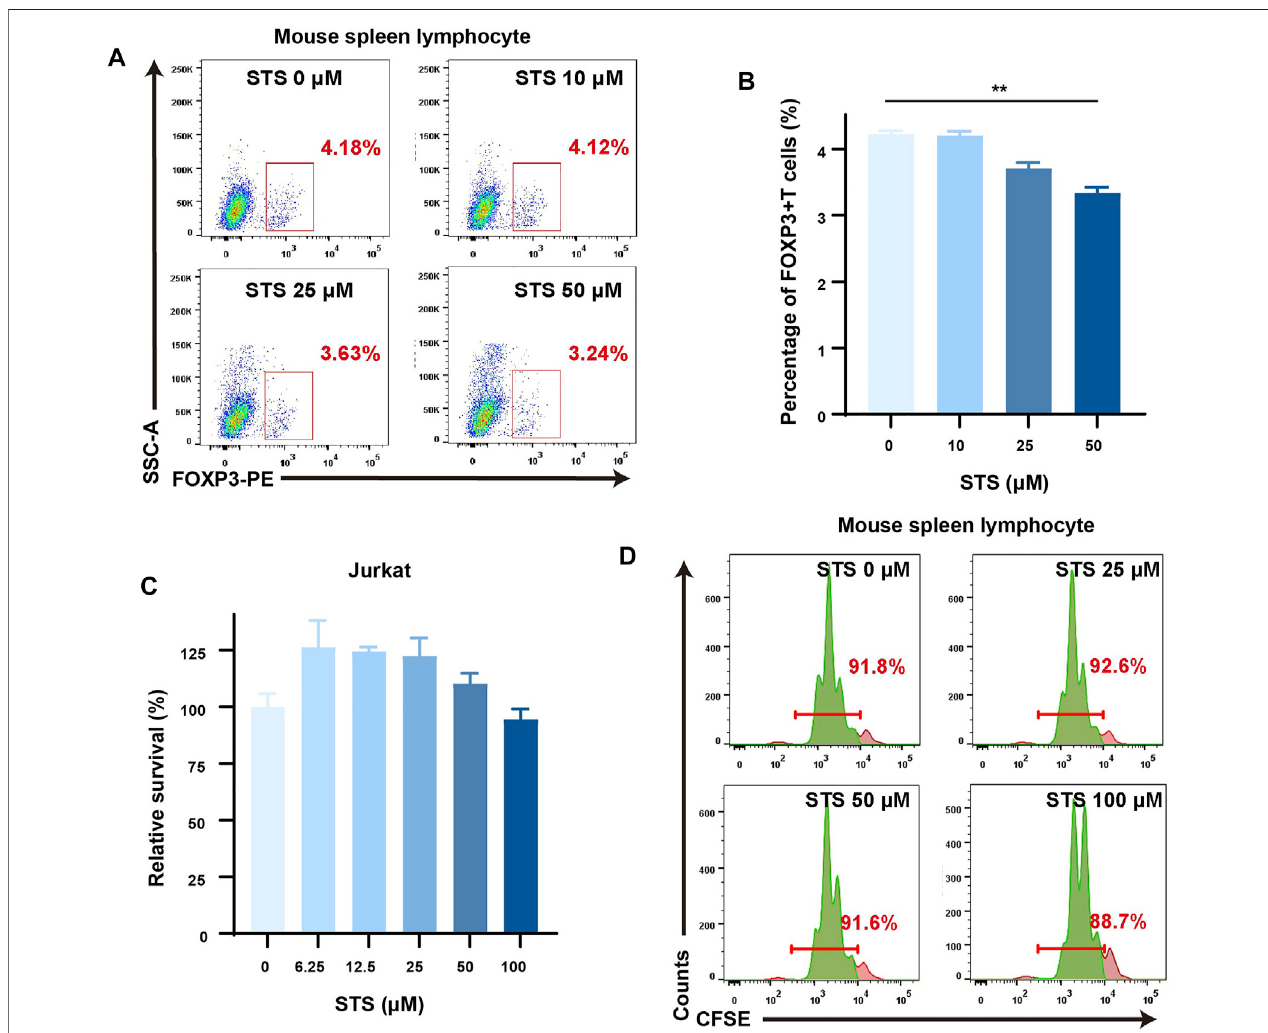
FIGURE 3 | STS reduced the percentage of Treg cells with a slight effect on the proliferation of lymphocytes. (A) STS decreased the percentage of Tregs. Flow cytometry was employed to analyze the percentage of Tregs in the coculture system of murine spleen lymphocytes and CT26 after STS treatment for 48 h. The gate of Tregs was from Zombie − CD45+ CD4+ cells. (B) Quanti fi cation of the percentage of Tregs. (C,D) STS had little effect on the proliferation of lymphocytes. Survival diagram of Jurkat cells after treatment with STS for 72 h (C) . CFSE staining was used to analyze the in fl uence on the proliferation of mouse splenic lymphocytes after 48 h of treatment with STS by fl ow cytometry (D) . Statistical data are represented as the mean ± SD. ** p < 0.01 analyzed by ANOVA.